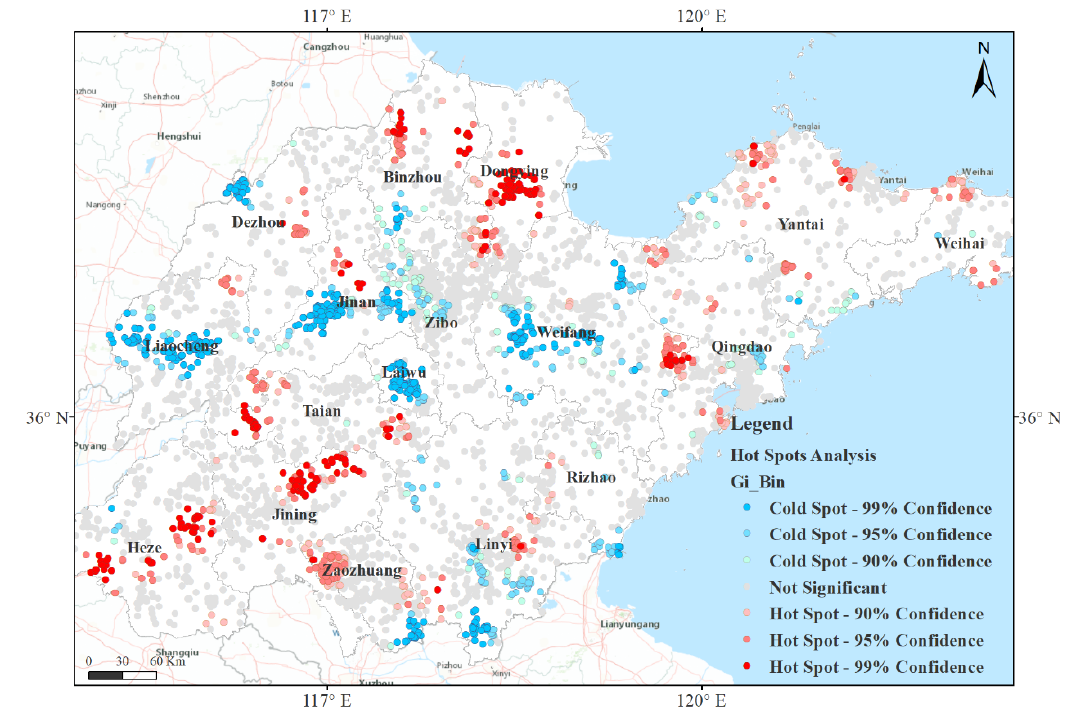
Figure 7. Hot spot analysis of public complaints about air pollution in Shandong Province from 2012 to 2018.